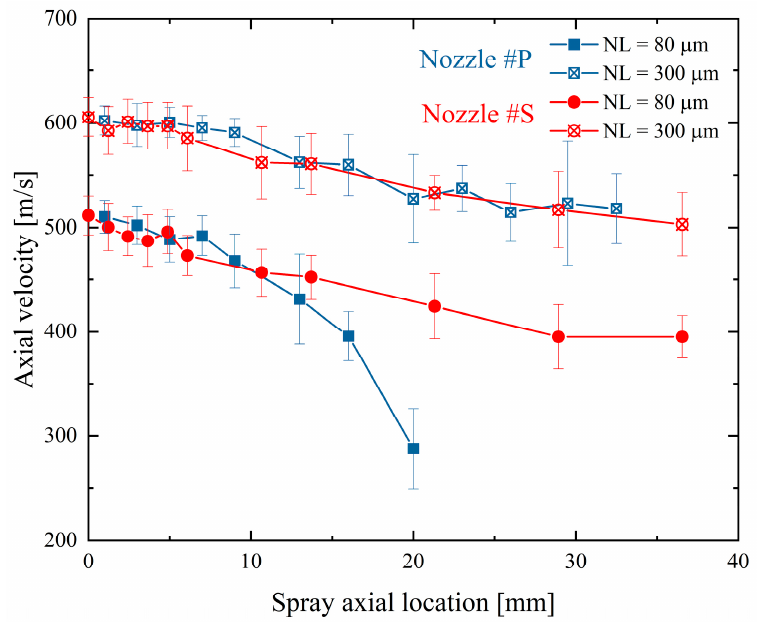
Figure 10. Spray velocity evolutions along the spray axis at the two different needle lifts.